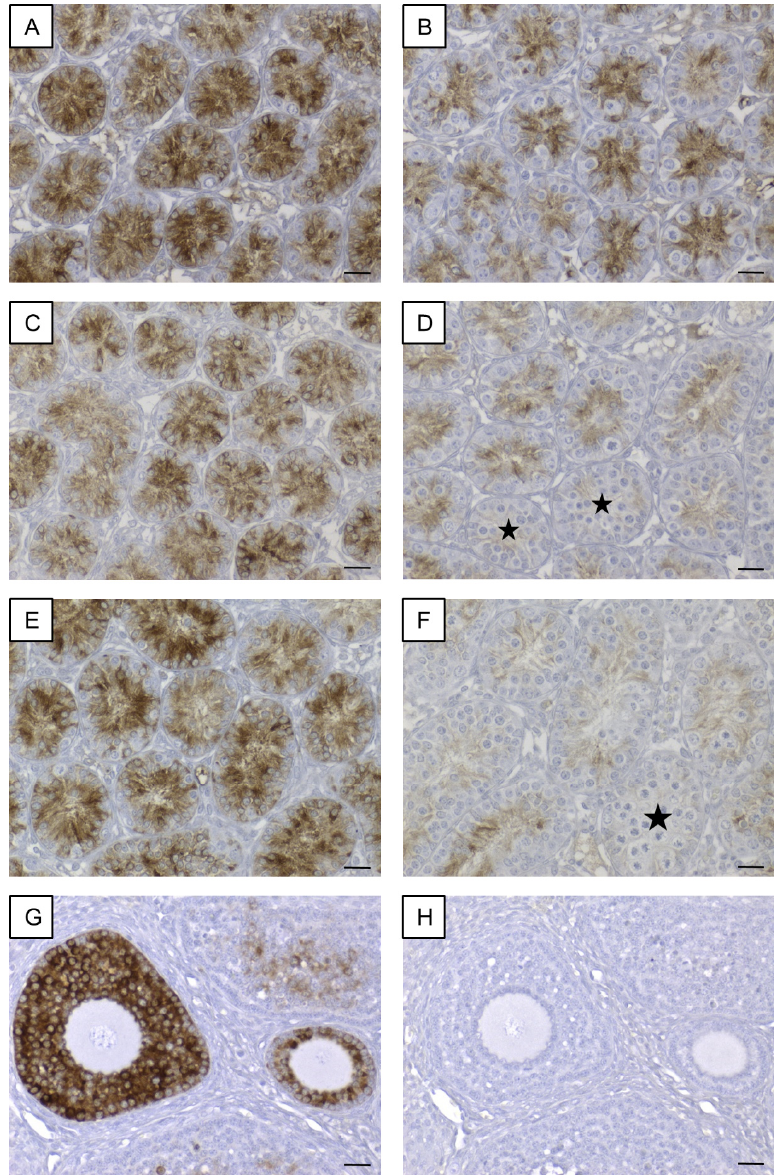
Figure 9. Immunohistochemical detection of AMH. ( A ) Strong immunoreaction in Sertoli cell cytoplasm of 8-day-old SCCx43KO mice. ( B ) Distinct, cytoplasmic immunosignal in Sertoli cells of 8-day-old WT littermates. ( C ) Sertoli cell cytoplasm of 10-day-old SCCx43KO animals still showed a strong immunostaining. ( D ) Immunoreaction weakened in Sertoli cells of 10-day-old WT littermates. First seminiferous tubules were almost immunonegative (asterisks) concomitant with the first appearance of spermatocytes. ( E ) In 12-day-old SCCx43KO mice, a strong, cytoplasmic immunosignal was still observed in Sertoli cells. ( F ) Faint or almost no (asterisk) immunostaining of Sertoli cell cytoplasm of WT animals. ( G ) Mouse ovary tissue as exemplary positive control. ( H ) Exemplary negative control of mouse ovary tissue. AMH: anti-Müllerian-Hormone, Cx43: connexin 43, SCCx43KO: Sertoli cell-specific Cx43 knockout, WT: wild type, scale bars: 20 µ m, numerical aperture: